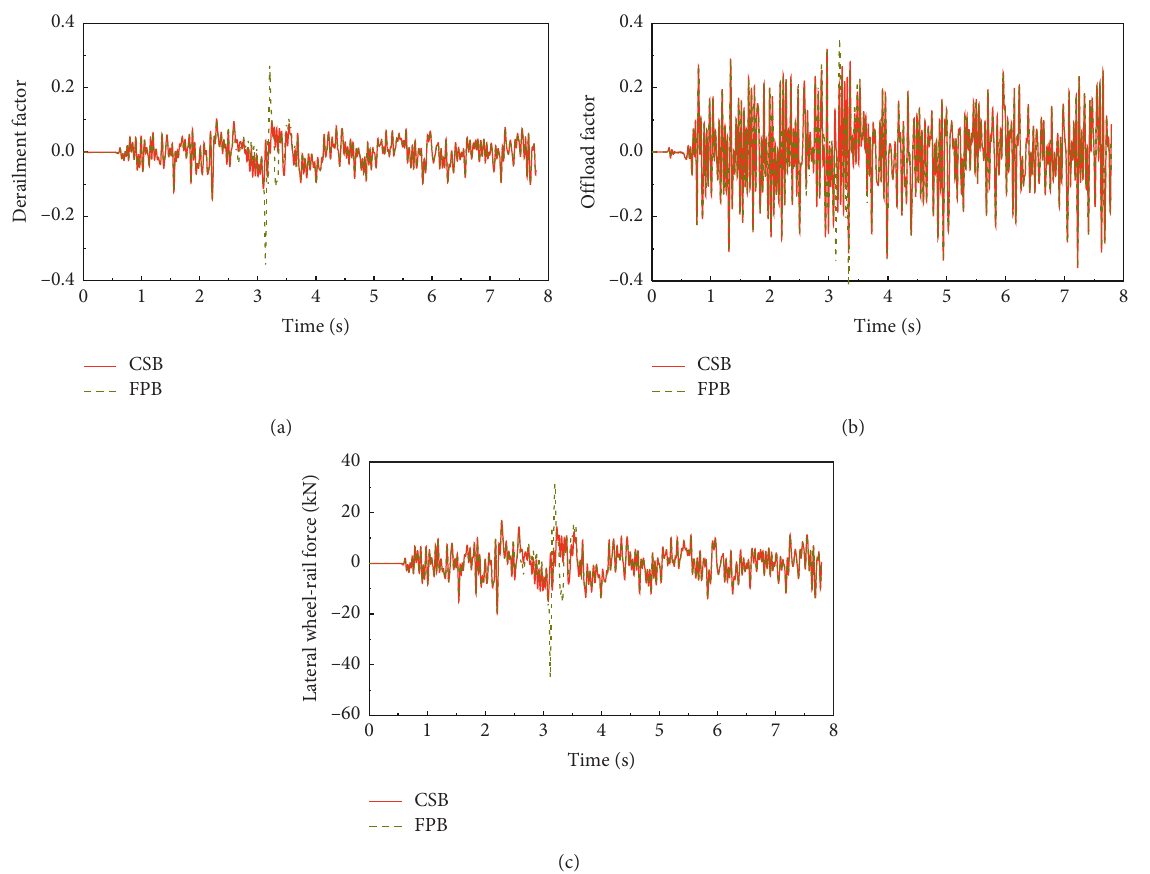
Figure 9: The comparison of the dynamic response of the train between FPB and CSB. (a) Derailment factor. (b) Offload factor. (c) Lateral wheel-rail